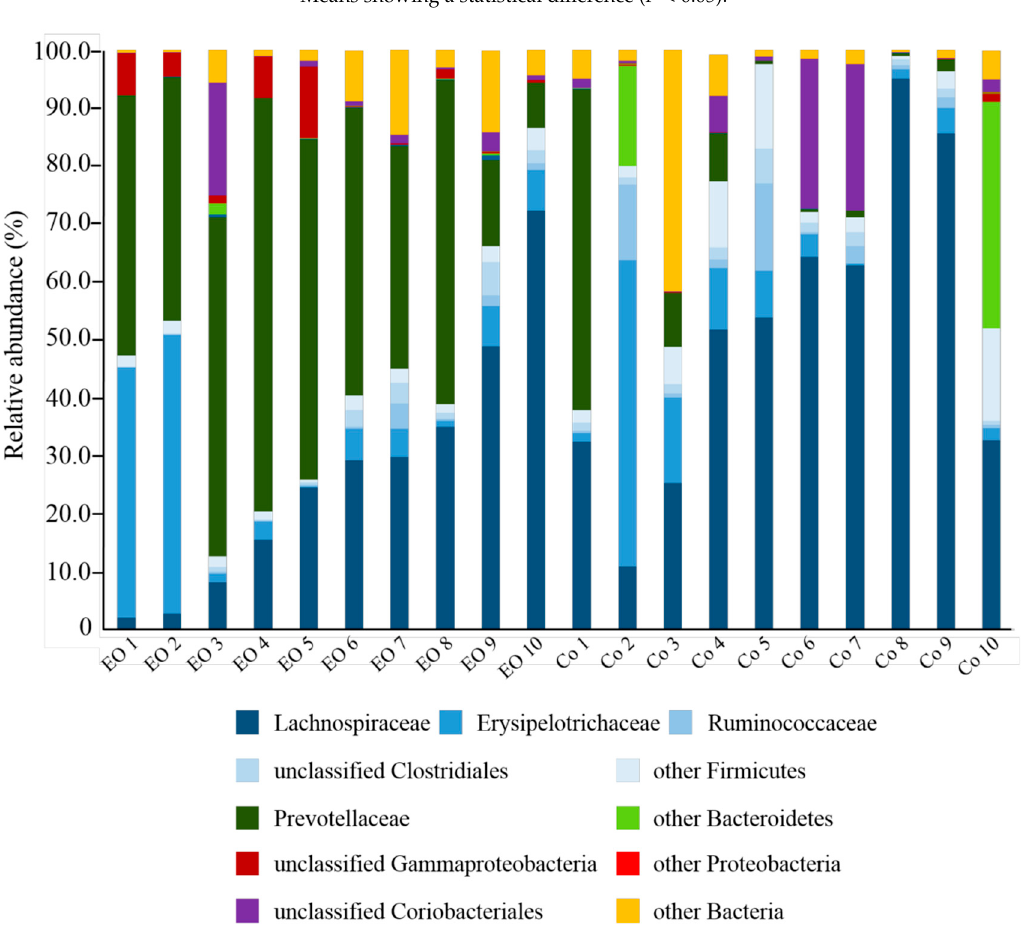
Figure 2. Family level taxonomic composition of rumen bacterial populations in EO-fed calves and controls (Co). Families belonging to the same phylum are represented by different shades of the same color: Firmicutes (blue), Bacteriodetes (green), Proteobacteria (red), and Actinobacteria (purple). Table 1. Relative abundance (%) of main bacterial taxonomic groups in the rumen of dairy calves fed an EO-supplemented or control diet. Values shown represent mean and standard error of the mean, respectively.